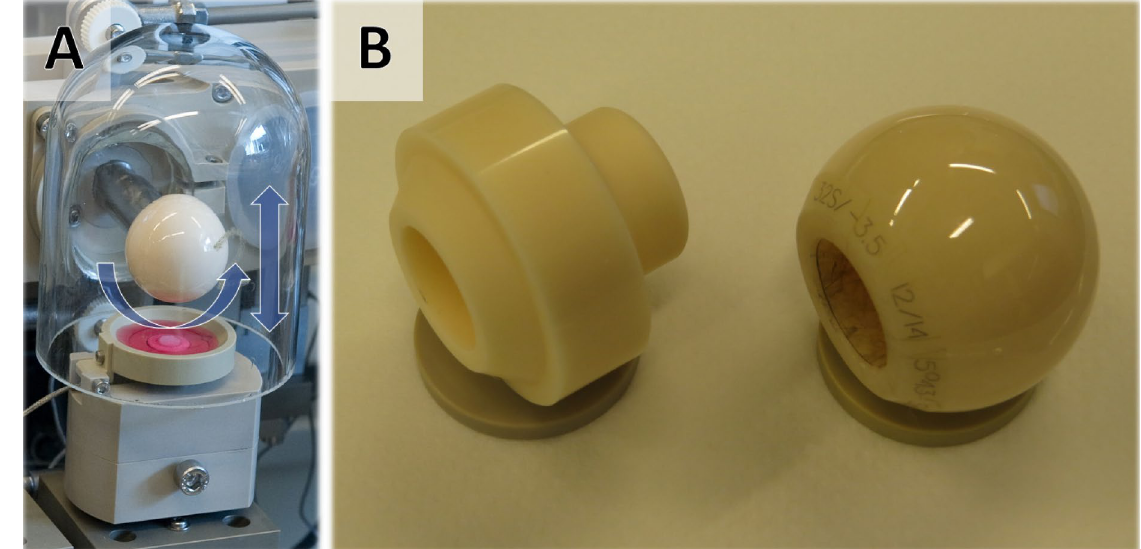
Figure 1. Multiaxial bioreactor and counterfaces. ( A ) Image of a loading station within the custom bioreactor. Arrows indicate rotational and vertical movement of the counterface. ( B ) Image of the two counterface types. Left: cylinder; right: